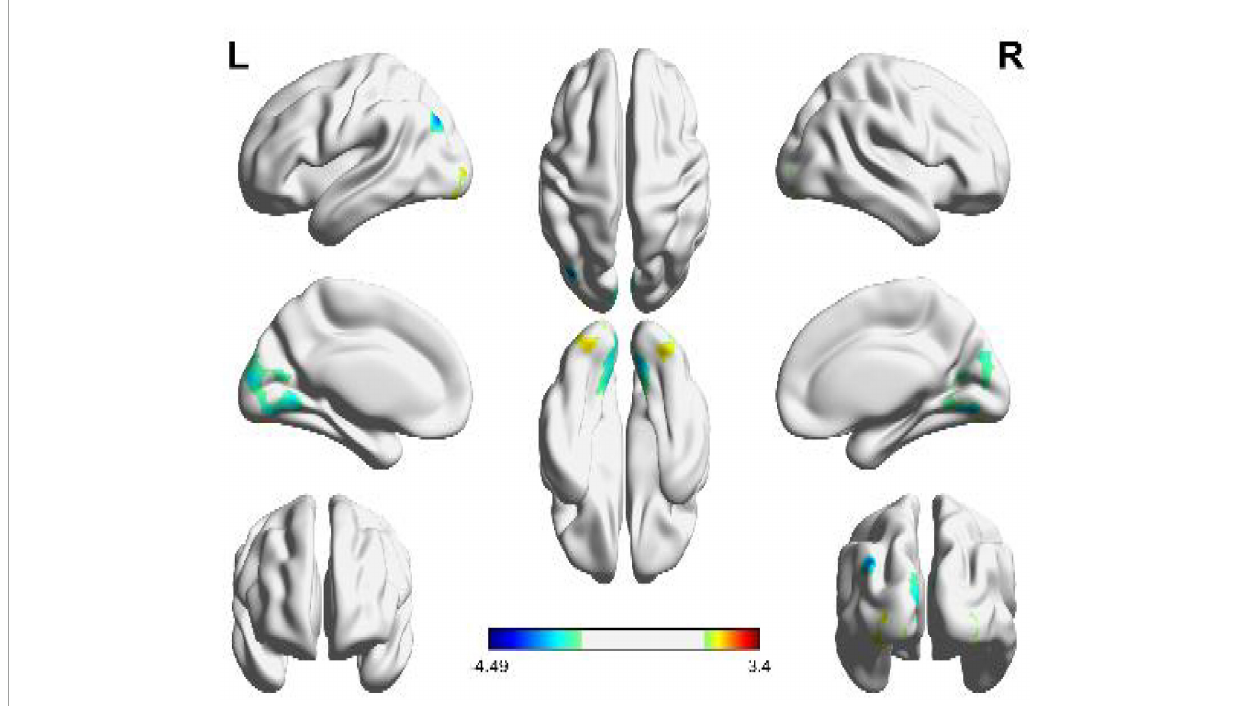
FIGURE2 Brain activation regions of geometric shapes (circular and angular shapes). The color bar indicates the size of the activation intensity. The values indicate positive or negative